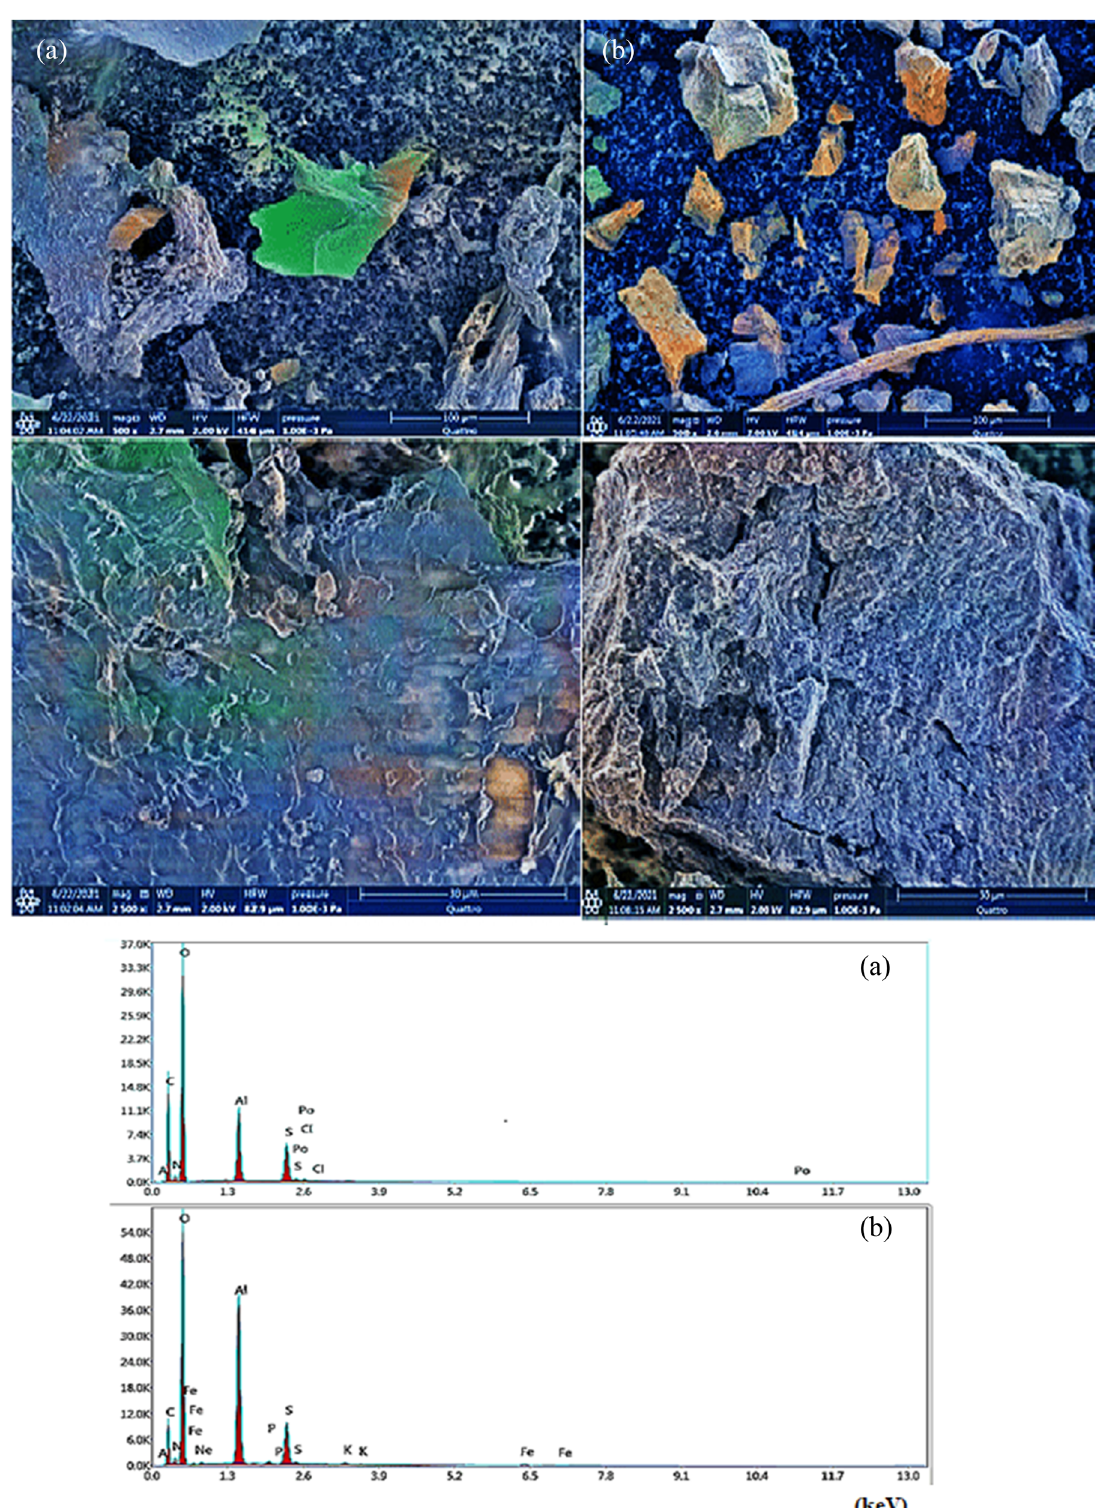
Figure 1: Morphology at magni fi cation 500 × and microanalysis by energy dispersive X - ray analysis of pumpkin pectin extracted from pulp ( a ) and peel ( b )